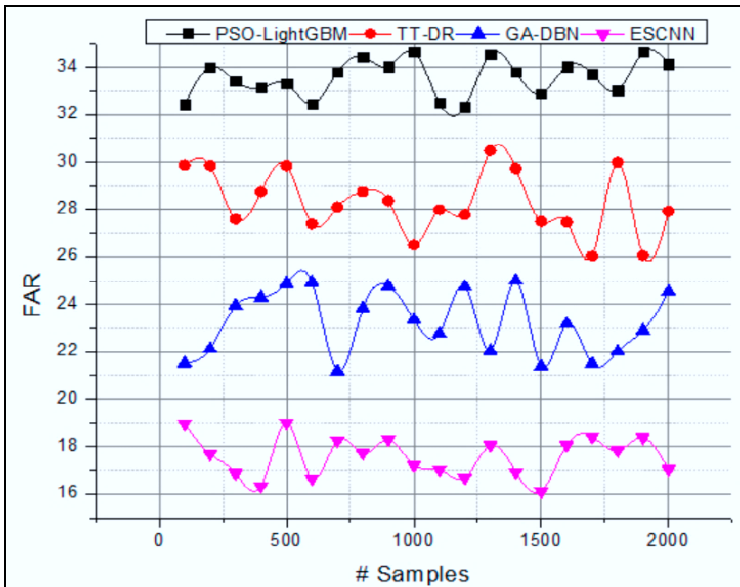
(b) Figure 6. Classification results: ( a ) Precision and ( b ) Recall. According to Figure 6a, the ESCNN approach predicts the abnormal activities, i.e., threat in IoT environment, by analyzing the user action sequences 𝐴 𝔲 (cid:3286), 1 , 𝐴 𝔲 (cid:3286), 2 , … 𝐴 𝔲 (cid:3286),(cid:3285) Using the LSTM layers, the extraction of ℌ 𝔲 (cid:3286),(cid:3285) = (cid:3419) ℎ 3 , 1 𝔲 (cid:3286),(cid:3285) , ℎ 3 , 2 𝔲 (cid:3286),(cid:3285) , … . . ℎ 3 ,(cid:3021)𝔲 (cid:3286),(cid:3285) (cid:3423) helps to identify the normal and abnormal activities while the user tries to execute the IoT environment. A sparse matrix is generated 𝔣𝔯𝔬𝔪 𝔱𝔥𝔢 𝔣𝔢𝔞𝔱𝔲𝔯𝔢𝔰 𝔐 𝔲 (cid:3286),(cid:3285) − (𝑁 𝔲 (cid:3286) ∗ 𝑉 𝔲 (cid:3286) ) . That minimizes the computation complexity while extracting different activities in the IoT. The successful